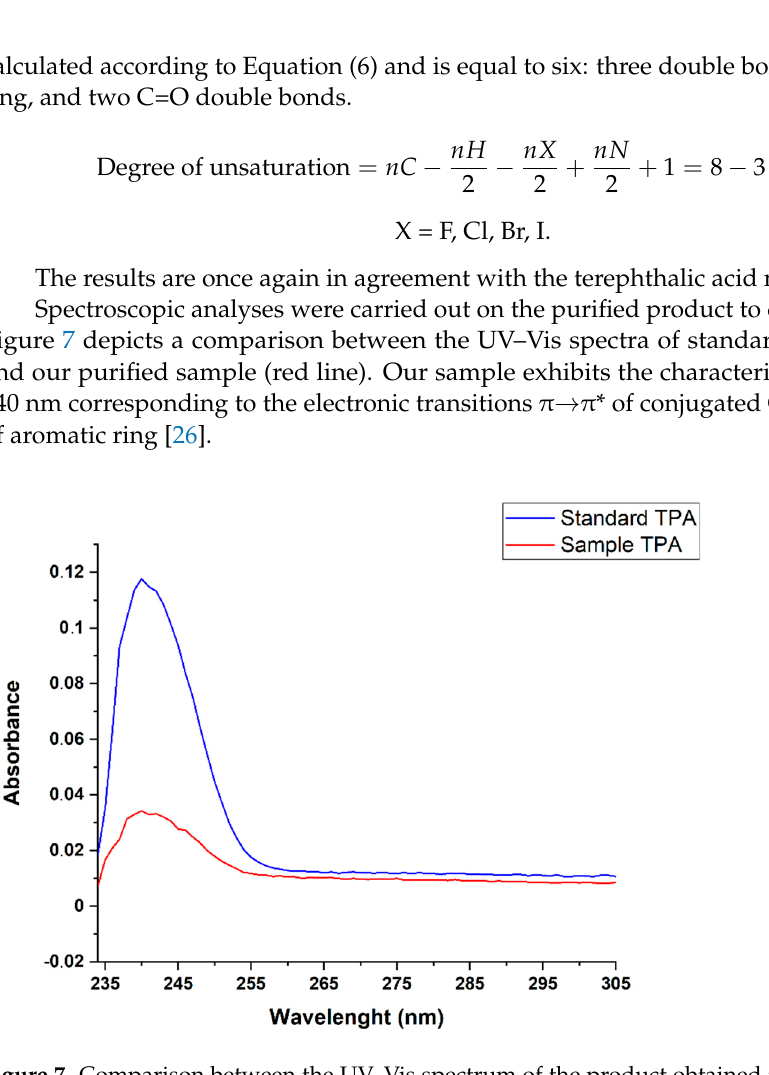
Figure 7. Comparison between the UV–Vis spectrum of the product obtained from test 2 (20 min) with that of the standard TPA.